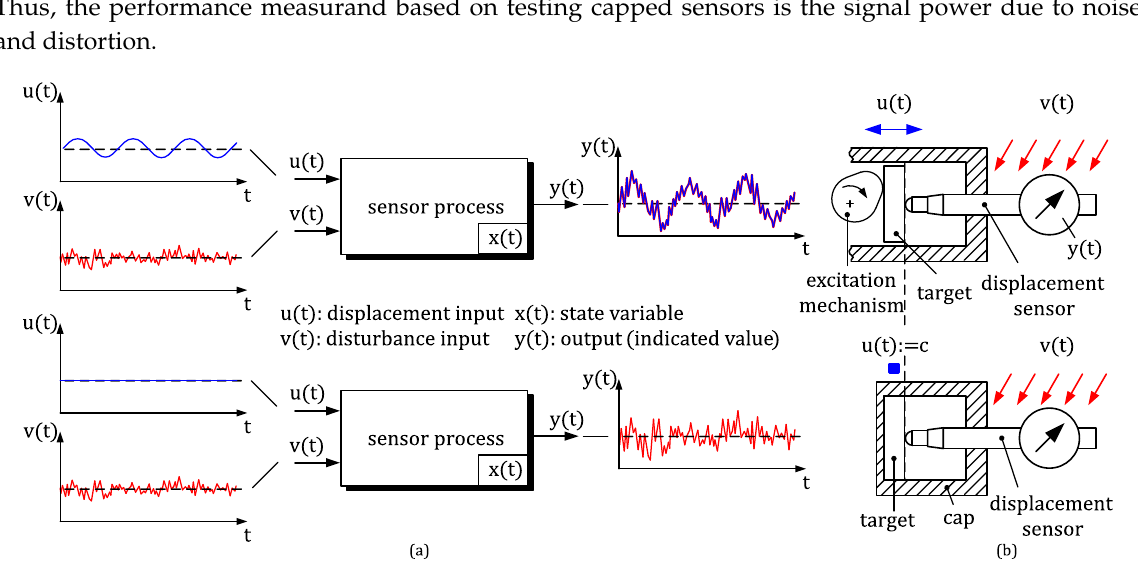
Figure 6. Determination of displacement sensor behavior with respect to mechanical displacement and disturbance input ( top : mechanical harmonic excitation; bottom : capped sensor): ( a ) schematic signal diagram representation; and ( b ) realization of calibration